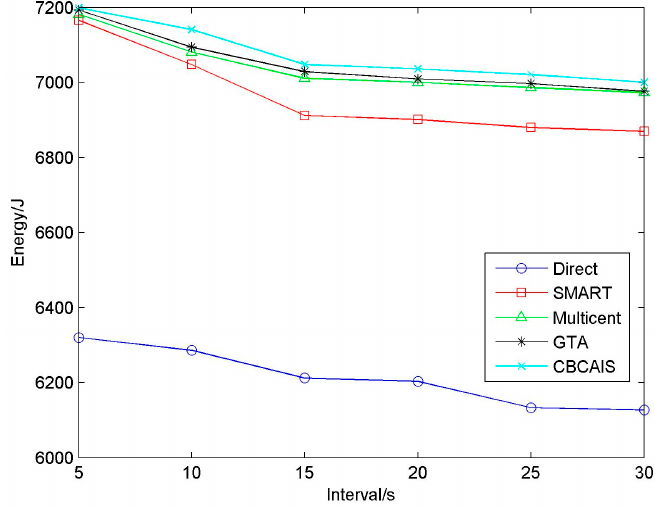
Figure 20. Energy for varying message generation intervals.